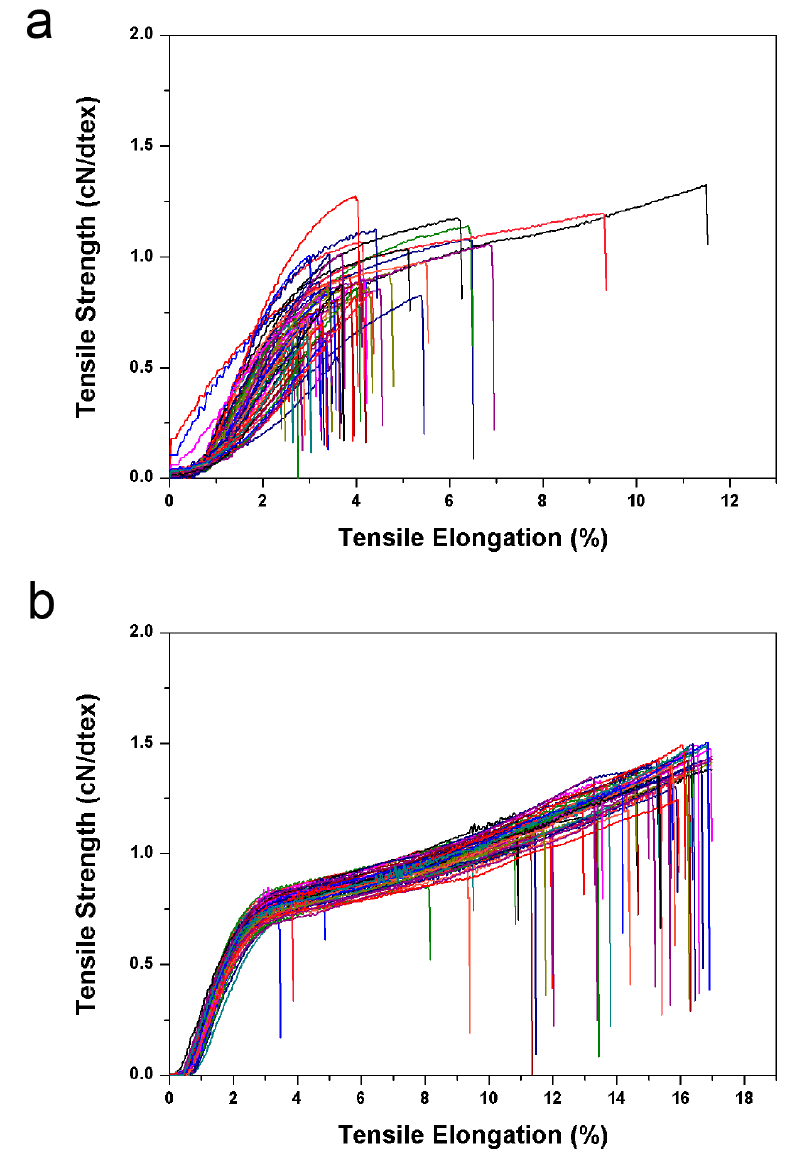
Figure 5. Tensile properties of ( a ) CTFs and ( b ) FTFs. Both fibres were tested 60 times to obtain average values.